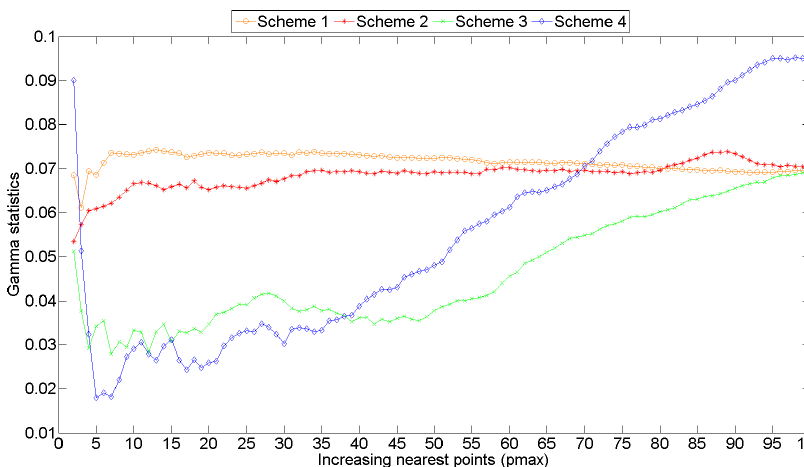
Figure 5. Gamma statistic ( (cid:48) ) variations for increasing the LLR p max value.